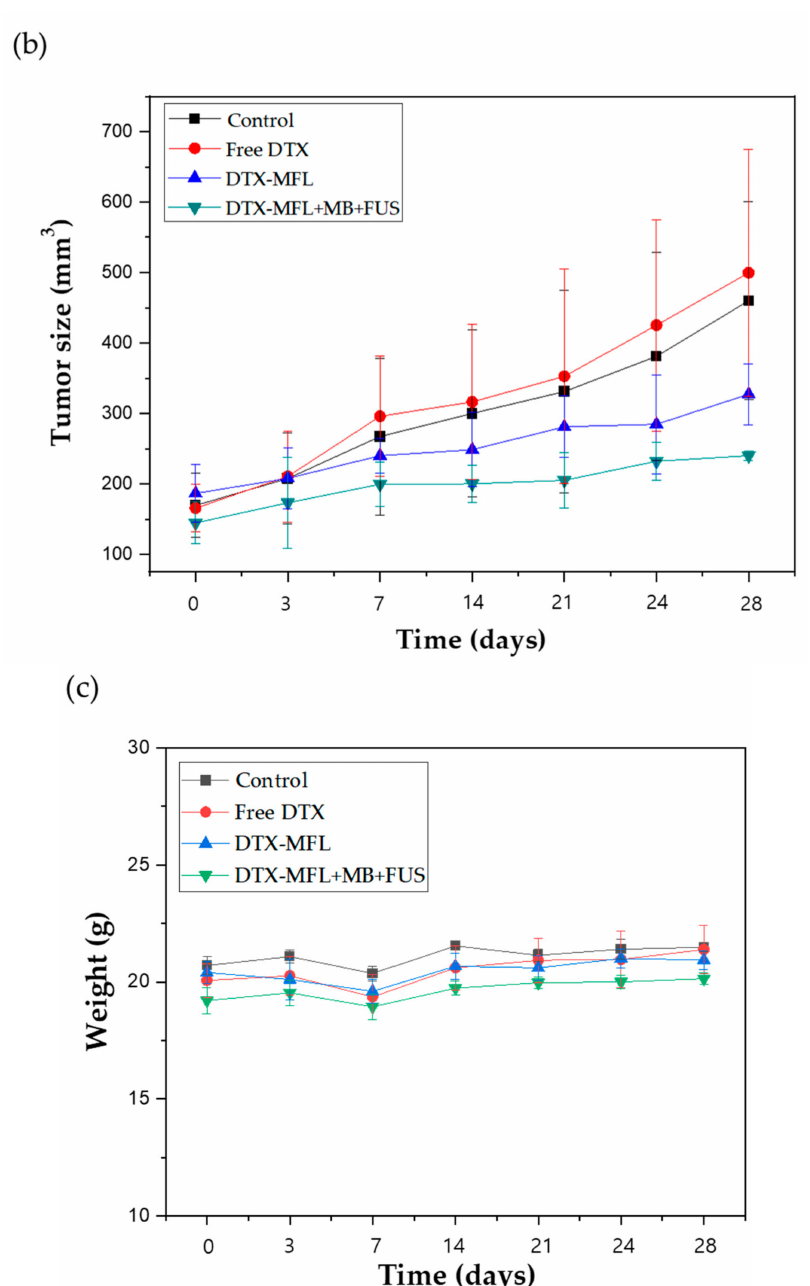
Figure 4. ( a ) In vivo e ffi cacy of MB + FUS; ( b ) in vivo e ffi cacy of docetaxel (free-DTX), docetaxel-loaded MFLs (DTX-MFLs), and docetaxel-loaded MFLs treated with microbubbles and focused ultrasound (DTX-MFLs + MB + FUS); ( c ) mouse body